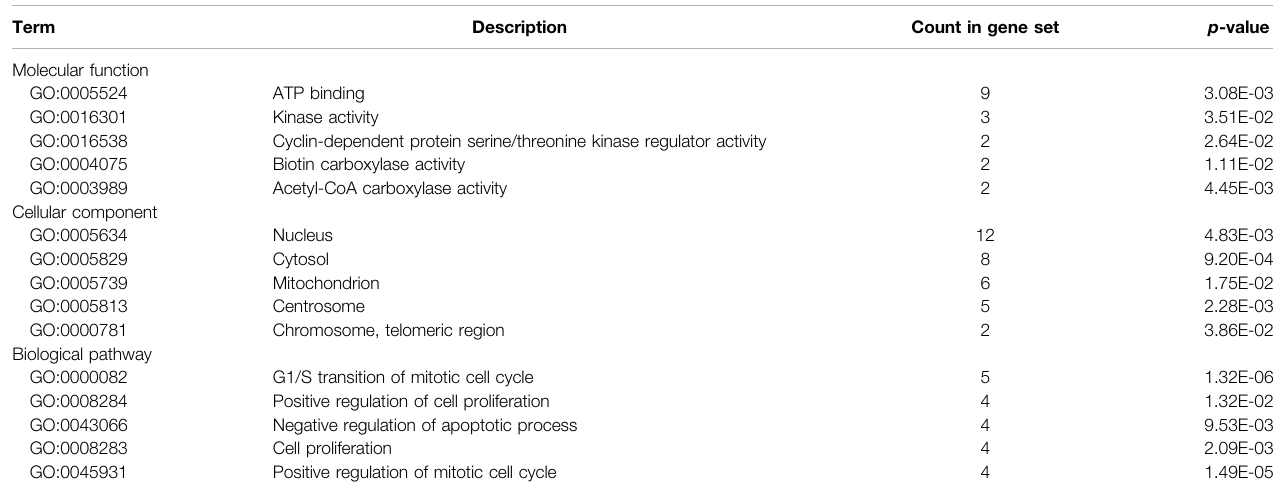
TABLE 4 | The top 5 terms of GO enrichment analysis results of co-expressed genes with FATP5. Term Description Count in gene set p